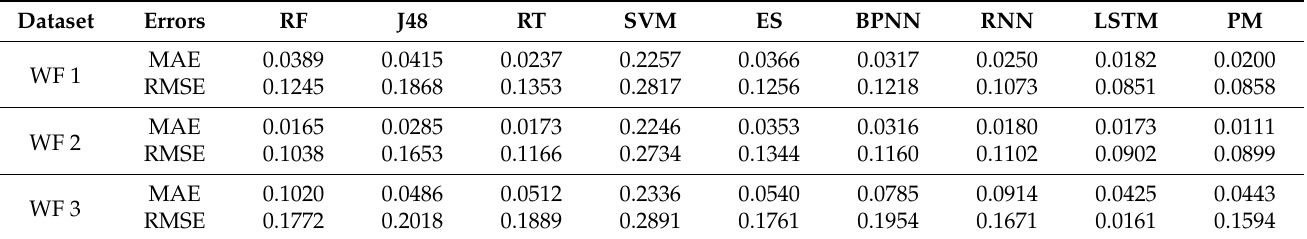
Table 4. Comparison of related forecasting models with the proposed model in terms of MAE and RMSE forecasting errors for windfarms.